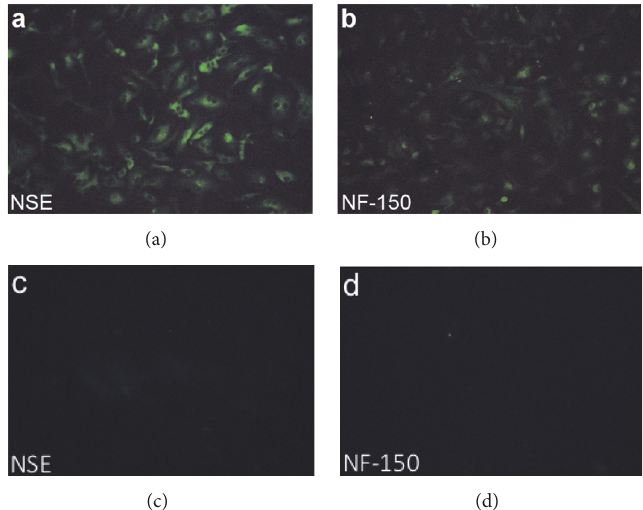
Figure 3: Expression of neural cell markers in cells grown in 10% FBS (2 weeks). Staining for NSE (a) and NF-150 (b) was positive in cells with polars. Negative control of NSE (c) and NF-150 (d) was also shown.